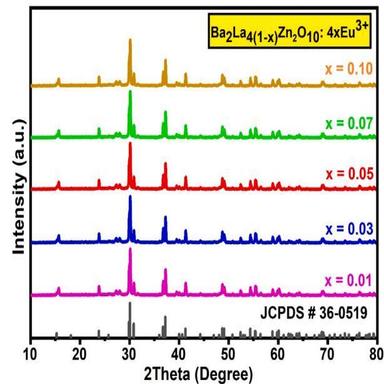
Collective Powder XRD outlines of Ba2La4(1-x)Zn2O10: 4xEu3+ (x = 0.01–0.10) nanophosphor showing complete alliance with the standard host patterns.